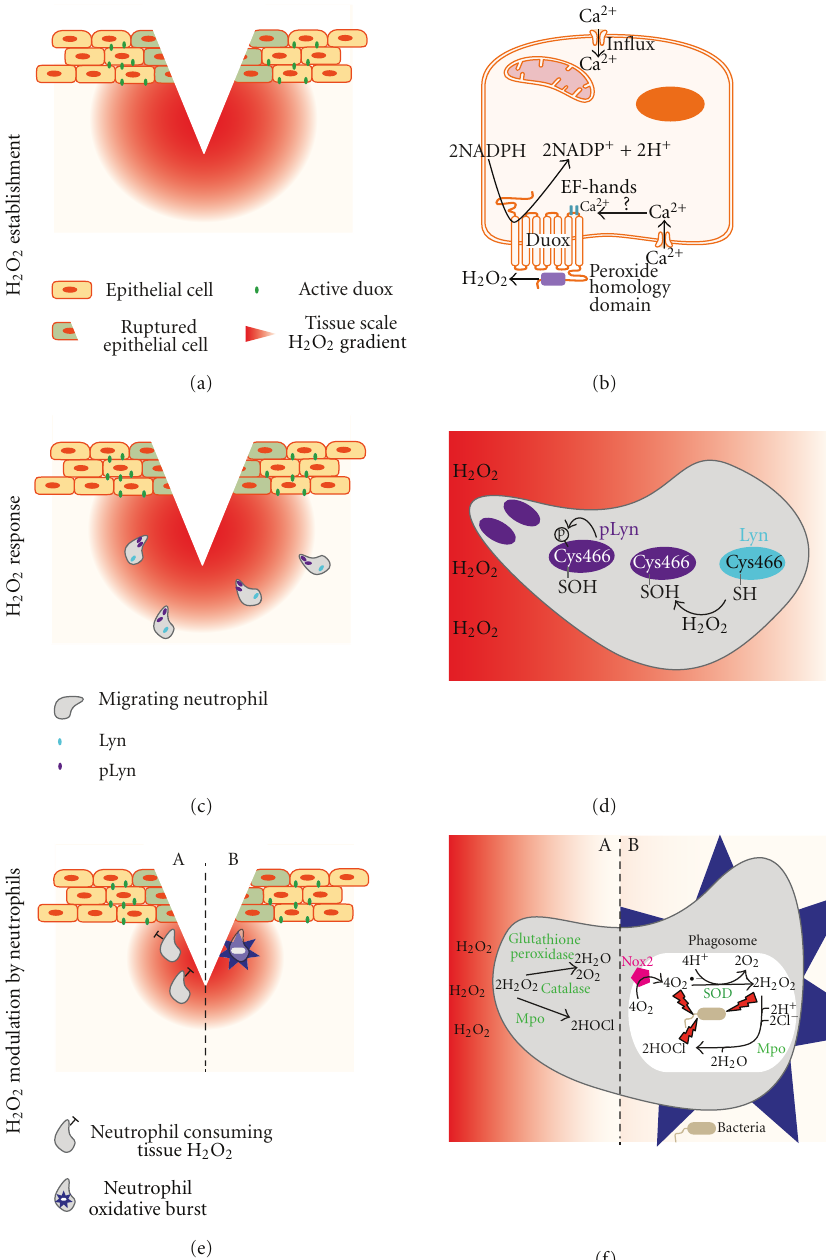
Figure 1: The role of hydrogen peroxide during the inflammatory response. (a) Upon tissue injury/trauma, epithelial cells adjacent to damaged cells activate the NADPH oxidase, Duox. Duox generates and establishes a localised tissue scale gradient of hydrogen peroxide, (b) Potential cellular events that result in Duox activation in epithelial cells. Disruption of epithelial cell membranes by mechanical trauma could lead to an increased influx of calcium in adjacent cells. Calcium binding to the EF-hand domain of Duox (residing in plasma membranes of epithelial cells), may initiate generation of hydrogen peroxide. (c) A tissue scale gradient of hydrogen peroxide acts as the first attraction signal for leukocytes. (d) Neutrophils sense hydrogen peroxide emanating from the wound partly through Lyn, a Src family kinase. Oxidation of Cys466 activates Lyn, resulting in autophosphorylation (pLyn) and punctate appearance of pLyn at the neutrophil leading edge is observed. (e) At the site of injury, neutrophils may alter hydrogen peroxide levels, both by consuming epithelial-derived hydrogen peroxide (A) or by local production of hydrogen peroxide through oxidative bursts (B). (f) Antioxidants, such as glutathione peroxidase and catalase could catalyse the decomposition of hydrogen peroxide into oxygen and water, while myeloperoxidase (Mpo) may consume hydrogen peroxide to produce hypochlorous acid (A). Neutrophils are equipped with multiple mechanisms to kill foreign organisms, one of them being the generation of ROS. Upon activation, phagosomal Nox2 generates superoxide, which is further converted into hydrogen peroxide by superoxide dismutase (SOD). Hydrogen peroxide alone and in conjunction with hypochlorous acid, generated by myeloperoxidase and other ROS exert bactericidal functions